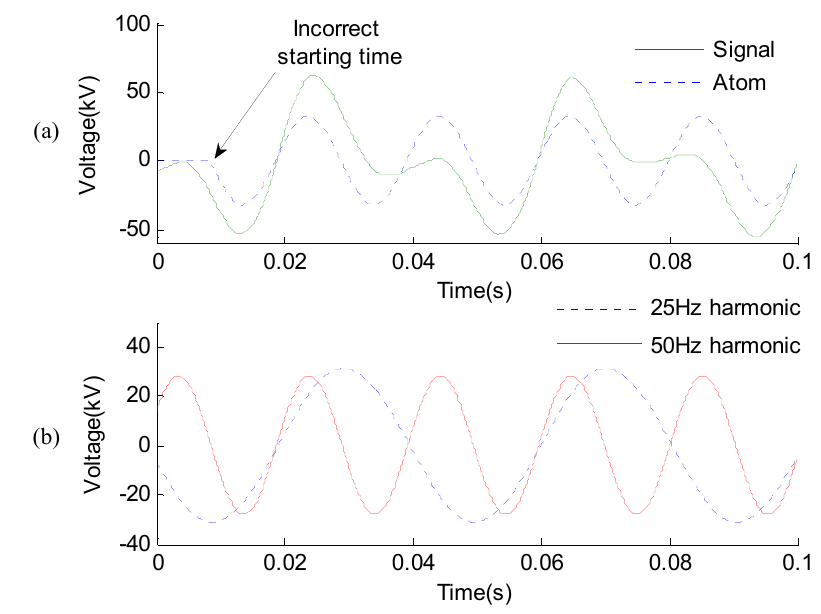
Figure 5. ( a ) An incorrect decomposition of sub-frequency ferroresonance; ( b ) Two main harmonic components of sub-frequency ferroresonance.